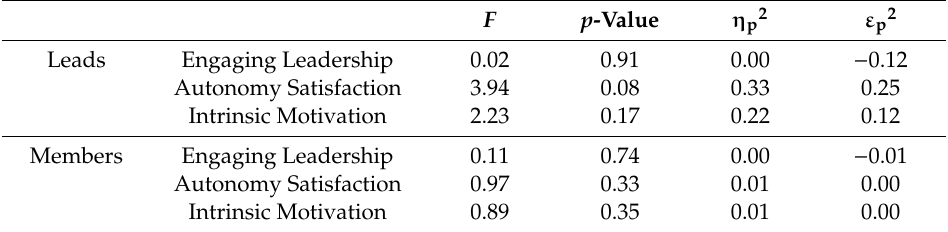
Table 5. Di ff erence of intervention e ff ects between intervention and control group. F p -Value η p2 ε p2 Leads Engaging Leadership